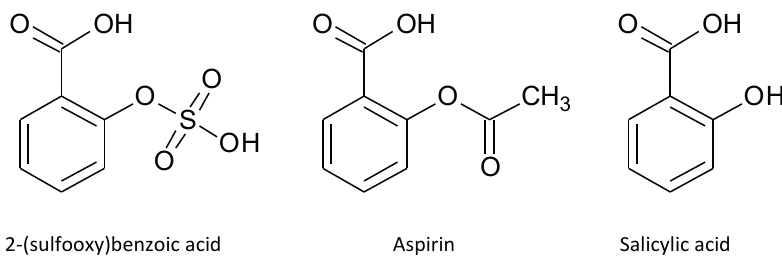
Figure 6. Chemical structures of 2-(sulfooxy)benzoic acid, aspirin and salicylic